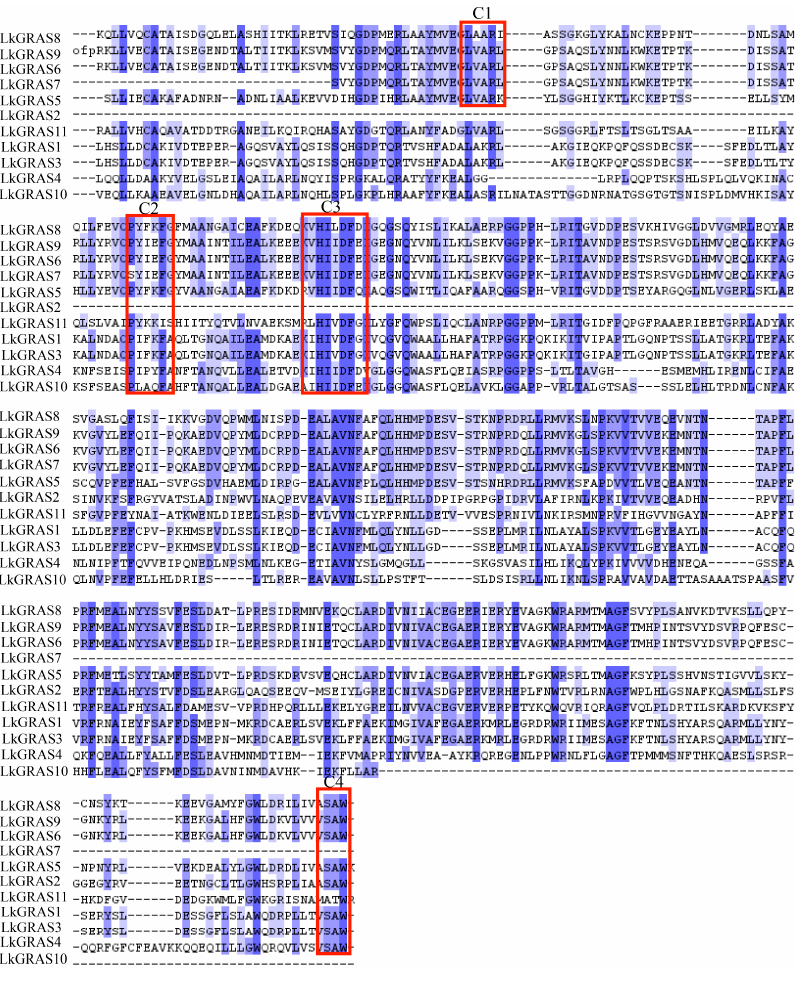
Figure 1. Multiple sequence alignments of the L. kaempferi GRAS gene family members. Blue shading marks identical residues, light blue shading marks conserved residues. Positions of the basic region of the GRAS domain and conserved domains ( C1 – C4 ) are demarcated by lines above